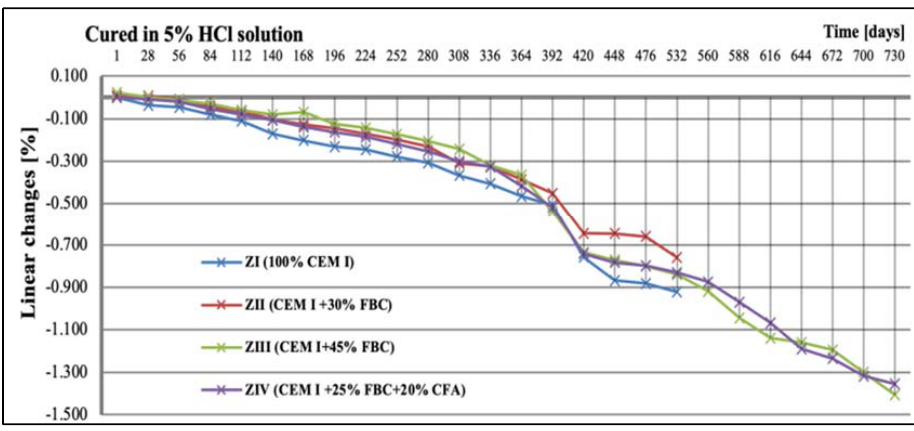
Figure 14. Linear changes of mortars cured in 5% HCl solution for 730 days.